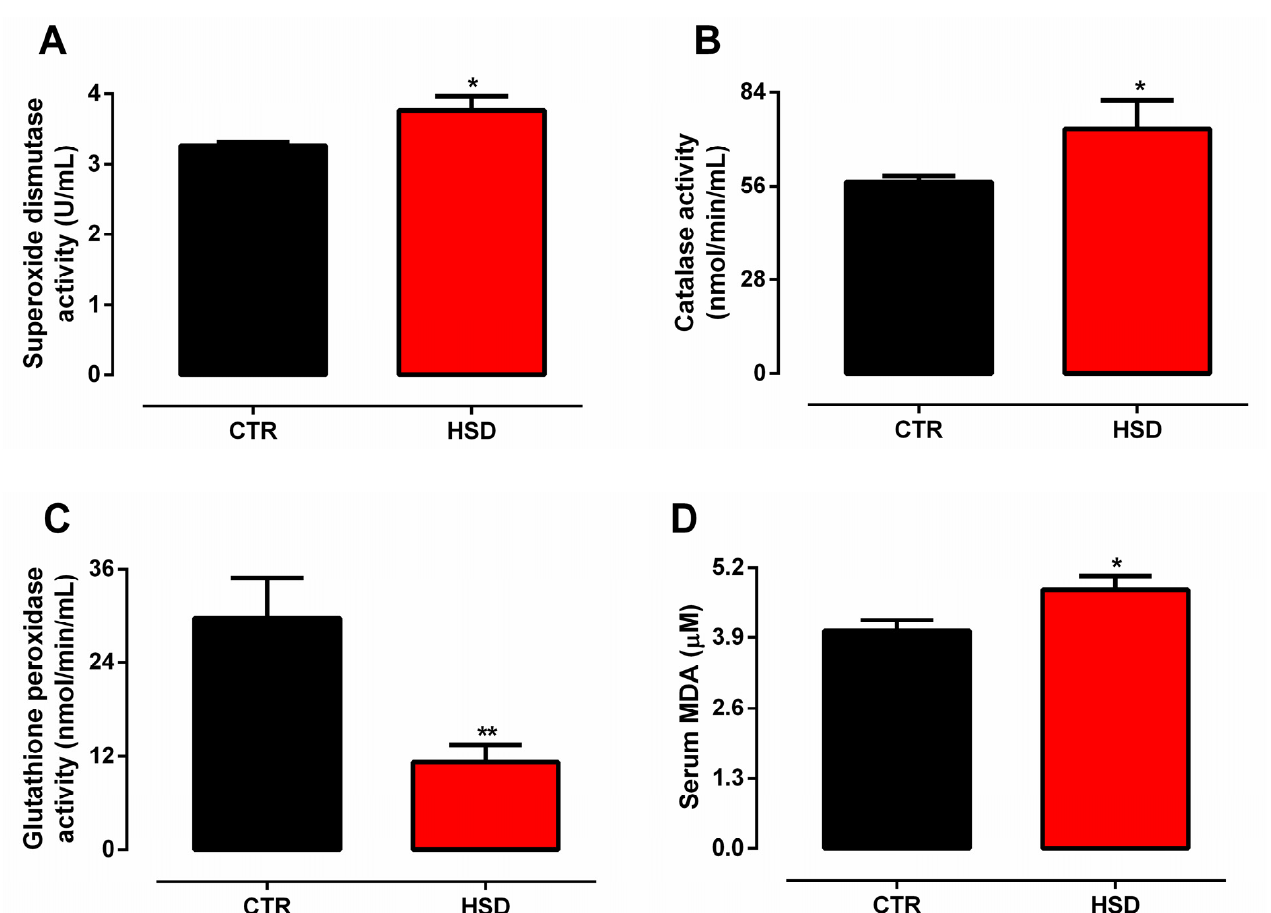
Figure 3. Serum redox profile. ( A ) Superoxide dismutase activity (U/mL), ( B ) catalase activity (nmol/min/mL), ( C ) glutathione peroxidase activity (nmol/min/mL), ( D ) serum MDA ( µ M) assessed in rats fed a standard chow (CTR, n = 7) and a high-sucrose diet (HSD, n = 7) until 6 months from weaning. Bars represent the mean ± SEM (unpaired t-test one-tailed). * p < 0.05, ** p < 0.01.